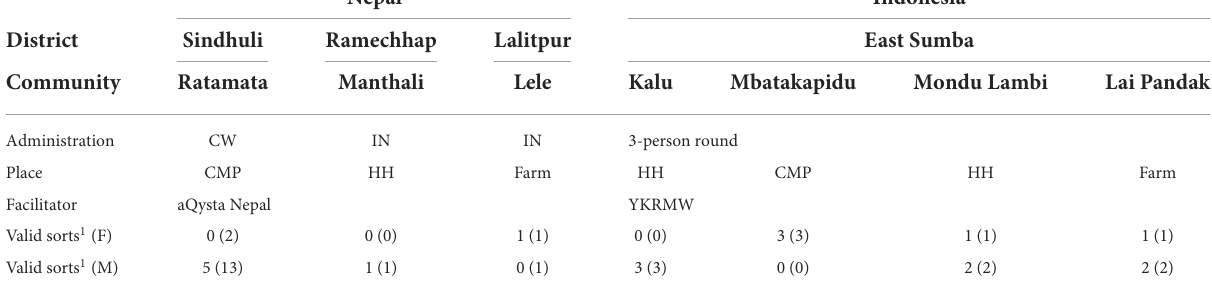
TABLE 3 Characteristics of sampled SF P-set.